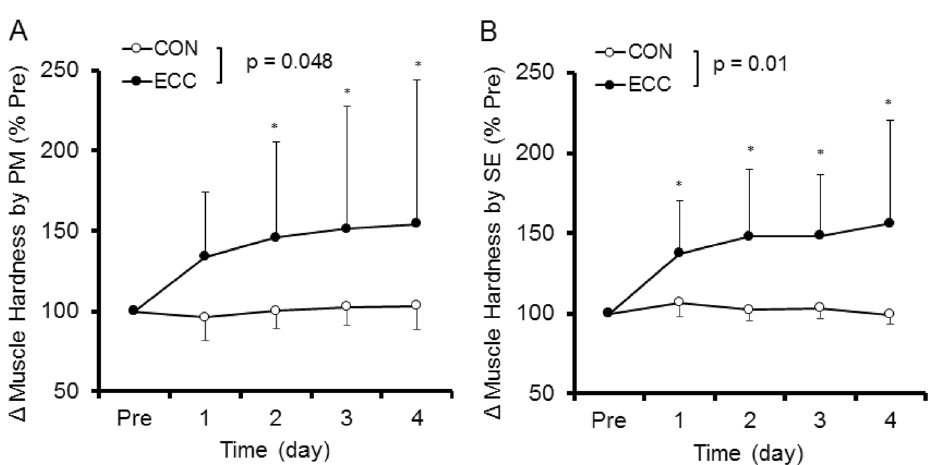
Figure 5. Normalized changes (mean ± SD) in flexed elbow angle (FANG, A ), relaxed elbow angle (RANG, B ) and extended elbow angle (EANG, C ) before (Pre) and 1–4 day after exercise. A significant ( p < 0.05) interaction effect was found between eccentric (ECC) and concentric (CON) conditions for FANG ( p < 0.001), RANG ( p < 0.01) and EANG ( p < 0.05). * shows a significant ( p < 0.05) difference from the baseline value.